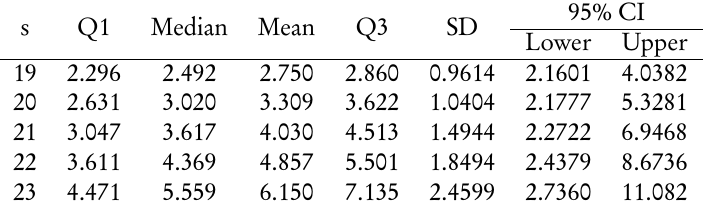
Sample based summary for one-sample predictive posterior based on Scheme 3 for real data